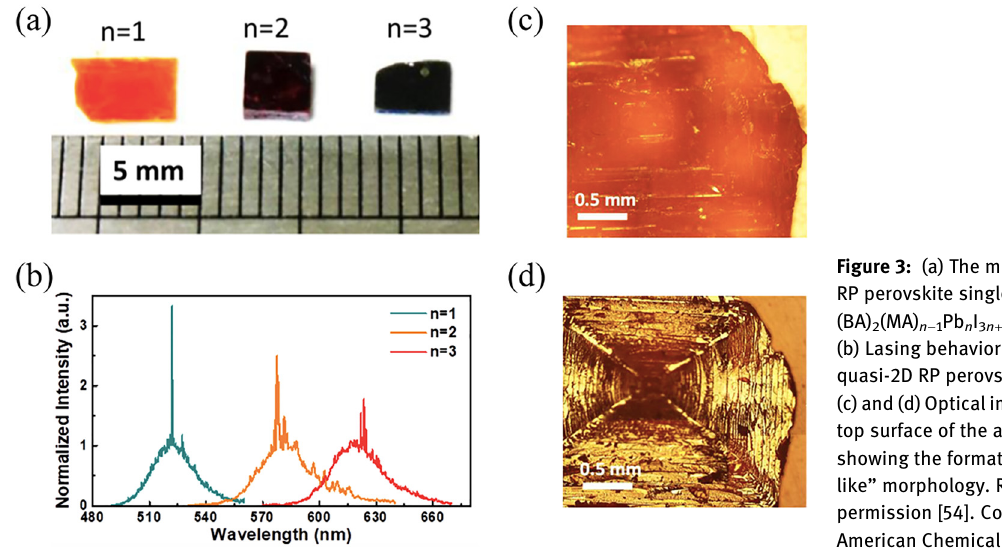
Figure 3: (a) The millimeter-sized quasi-2D RP perovskite single-crystals based on (BA) 2 (MA) n − 1 Pb n I 3 n + 1 with n values of 1, 2, 3. (b) Lasing behavior from the high-quality quasi-2D RP perovskite